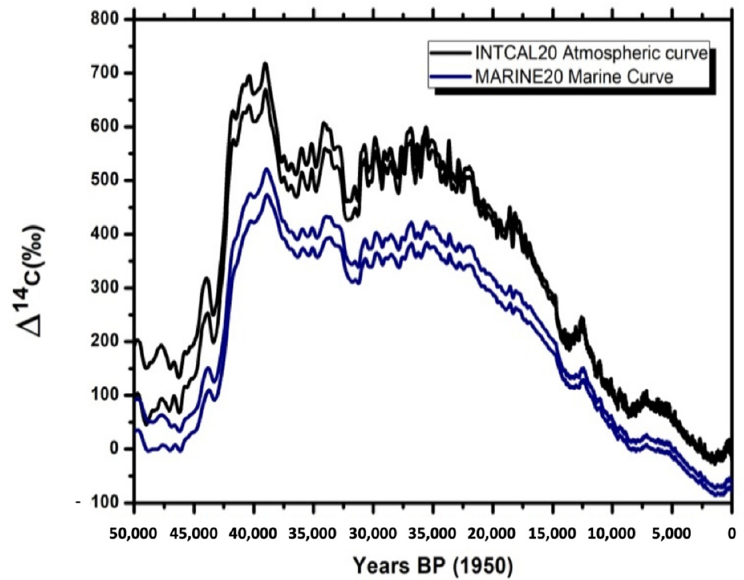
Figure 3. 14 C concentration in the last 55,000 years in the terrestrial atmosphere (grey curve) and in the ocean (blue curve). The marine curve refers to the global average (see text for details). The curves are obtained by using the INTCAL20 [13] and MARINE20 [14] data records.